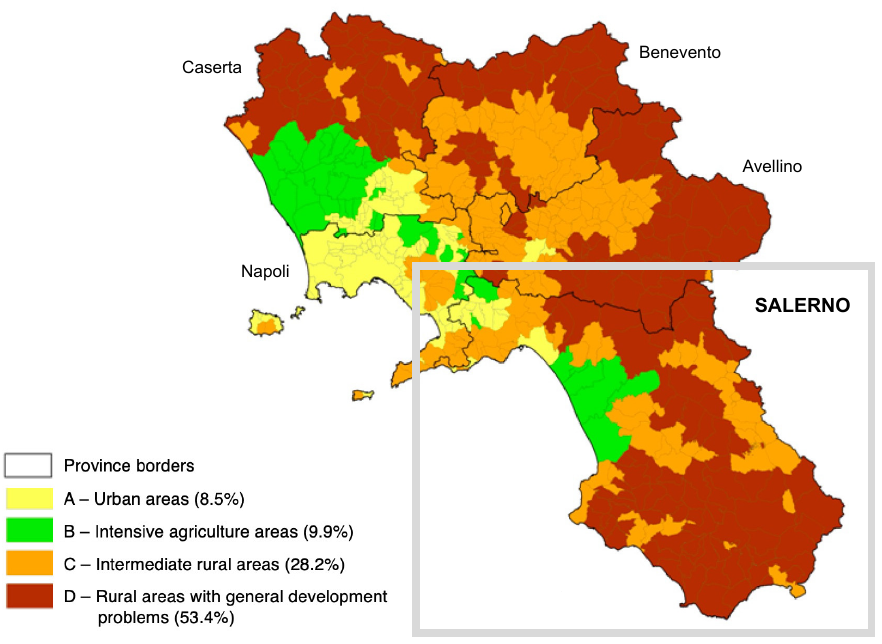
Figure 2. Regional classification of macro-areas adopted in the Italian Rural Development Programme 2014–2020 (figure adapted from the RDP of the Campania region).